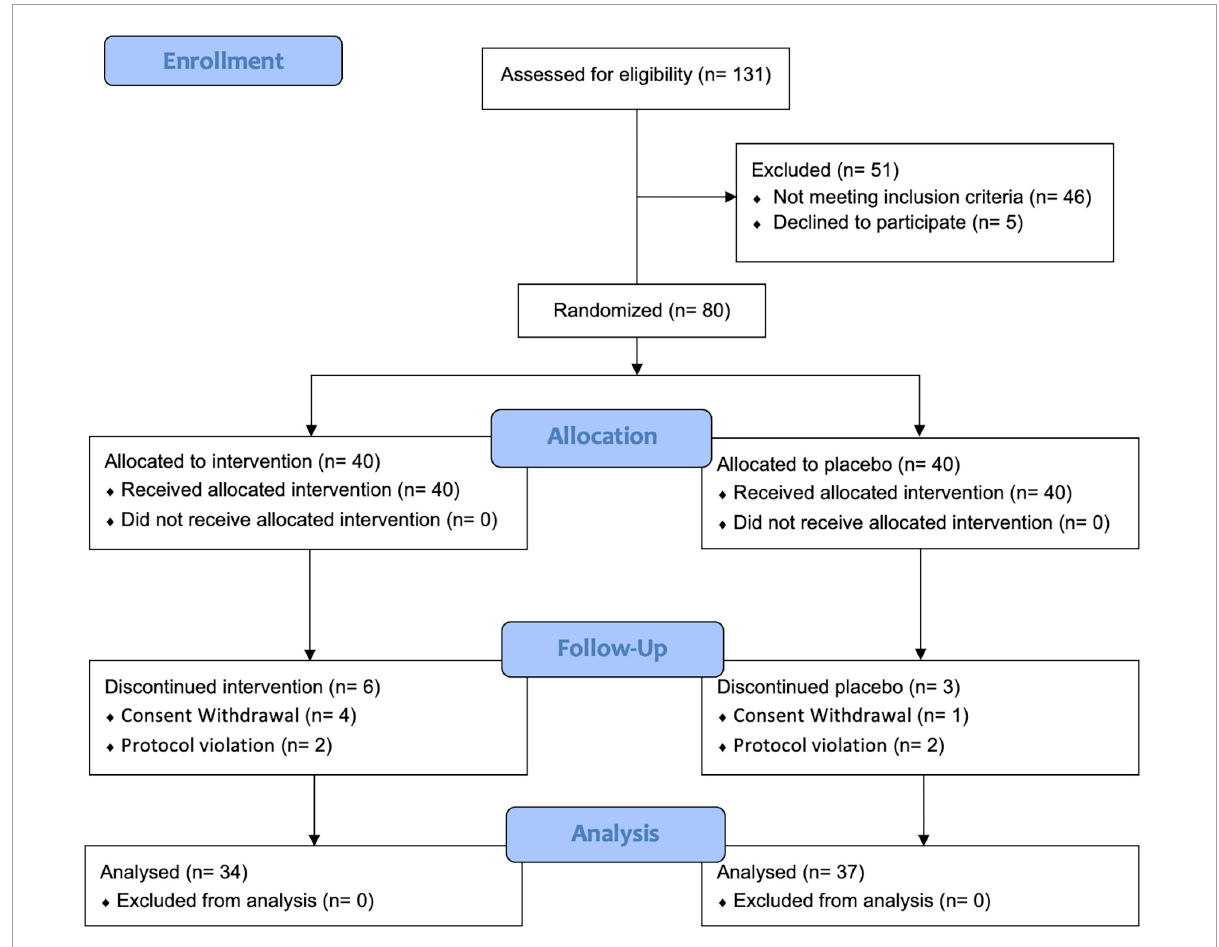
FIGURE1 Consolidated standards of reporting trials (CONSORT) flow